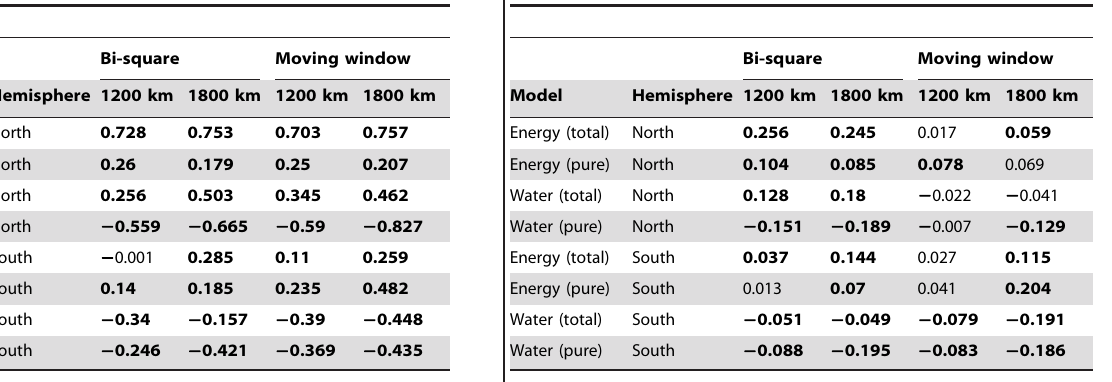
Table 1. Latitudinal trends in the amount of variation in American palm species richness locally explained by water and energy (OLS).